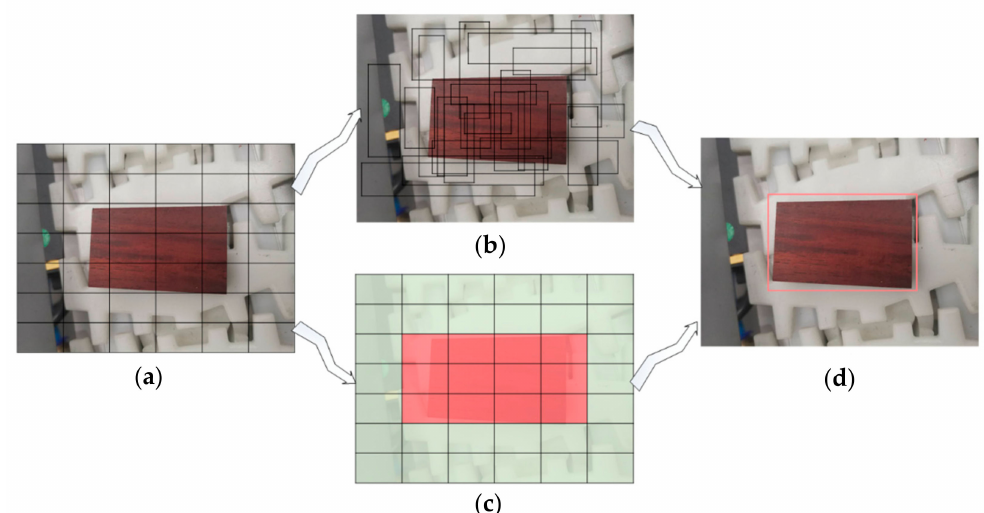
Figure 4. You Only Look Once (YOLO) algorithm detection process adopted in this paper. ( a ) Divided the input image into C × C network. ( b ) Target-predicting candidate boxes and confidence. ( c ) Target category probability map. ( d ) Complete target